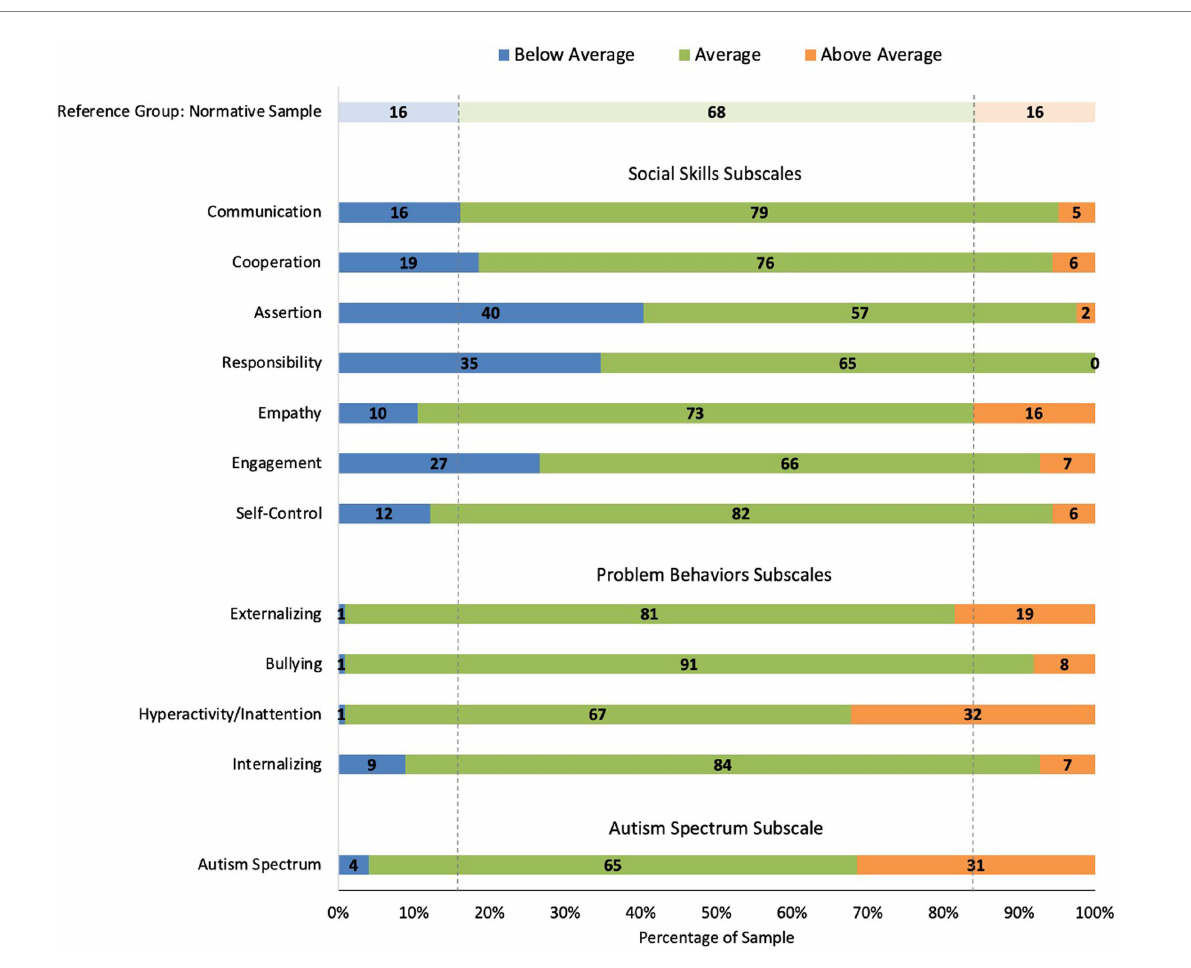
FIGURE 2 Percent of people with Down syndrome (DS) in each behavioral level category for the SSiS